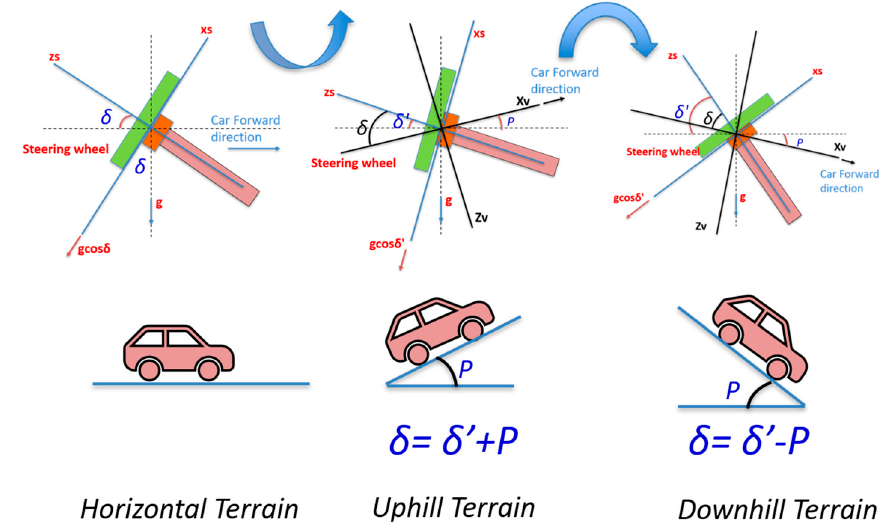
Figure 5. Different terrain types of land vehicle starting.